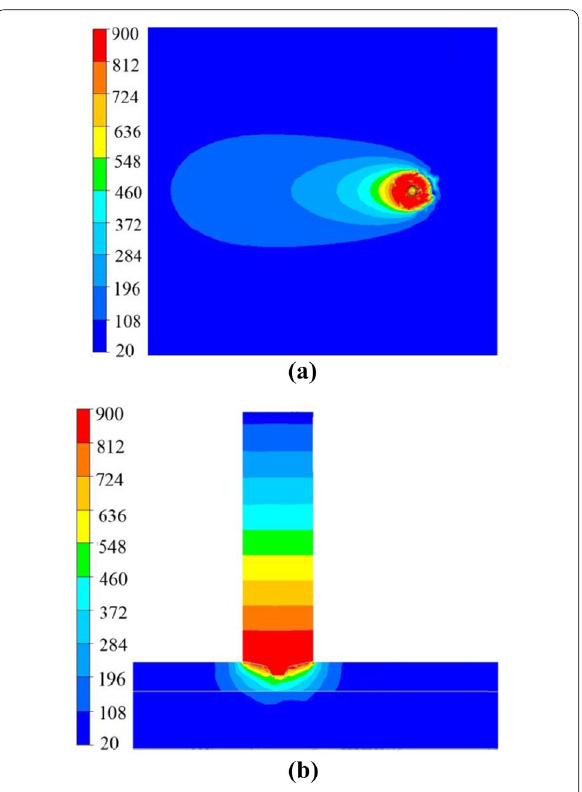
Figure 36 Temperature distribution at the tool and workpiece interface: ( a ) the top view, ( b ) the transverse direction [125,